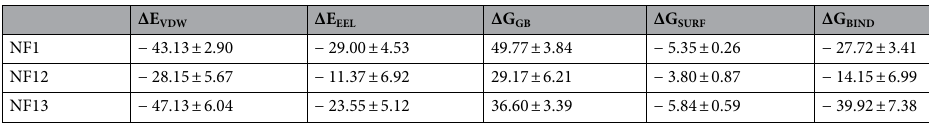
Table 4. Binding free energy estimation of compounds using MM-GBSA. *All energy terms are expressed in